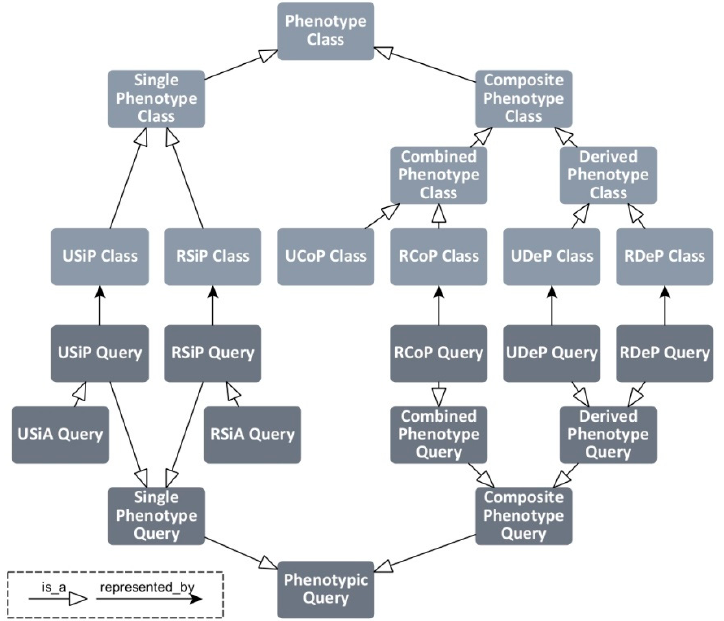
Figure 3. Displayed are types of phenotype classes and phenotypic queries as well as their relation- ships. Abbreviations used here are further described in upcoming sections.